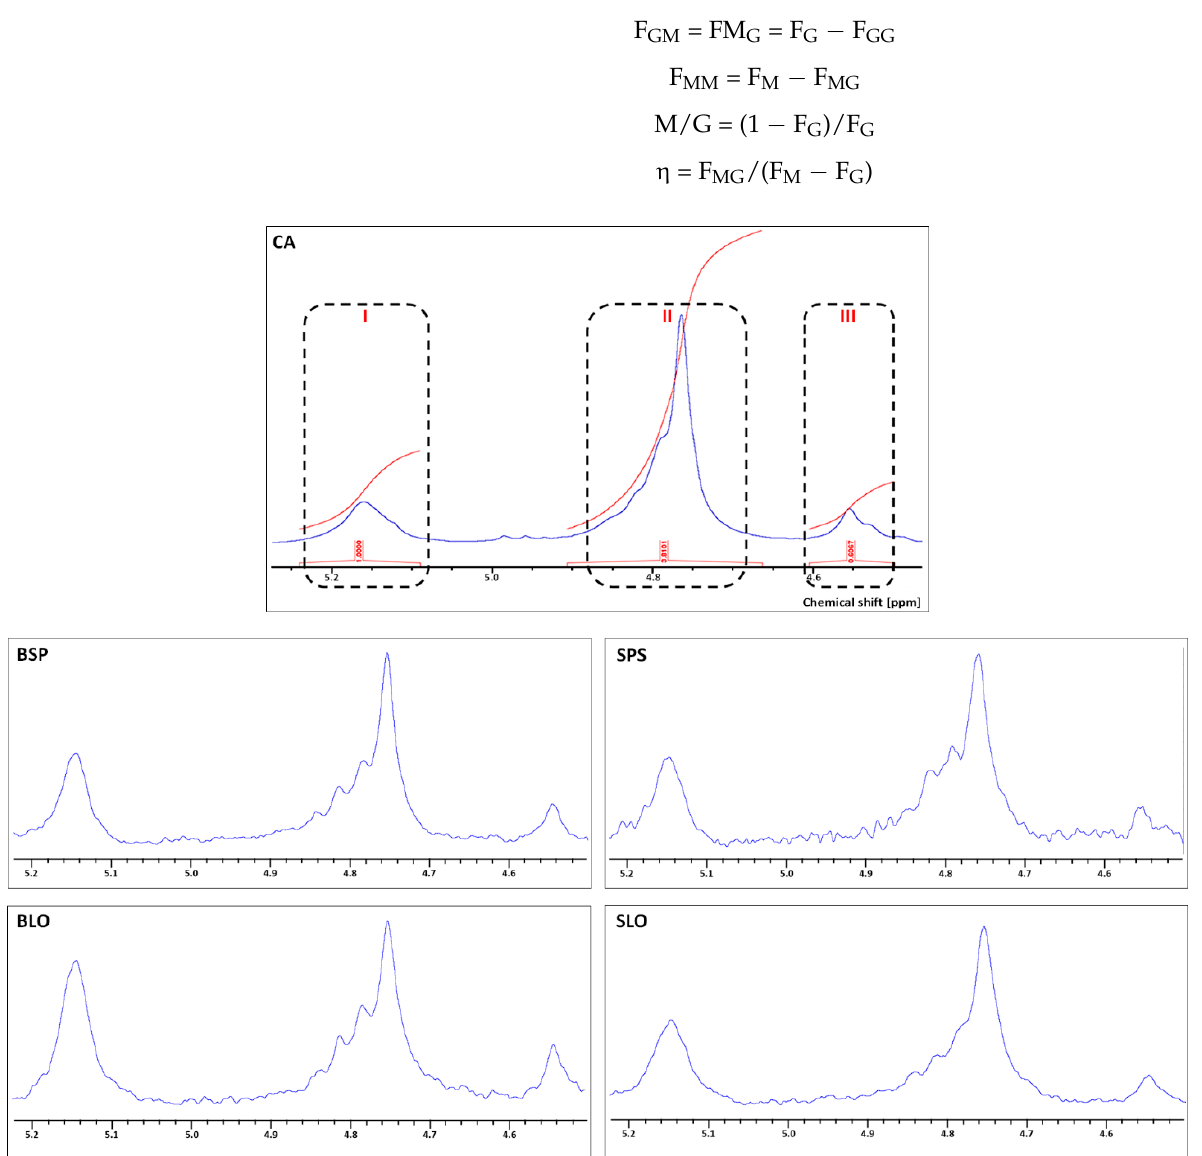
Figure 2. 1 H NMR spectra of commercial sodium alginate (CA) and alginates extracted from the blades of S. polyshides (BSP), stipes of S. polyshides (SPS), blades L. ochroleuca (BLO), and stipes of L. ochroleuca (SLO).